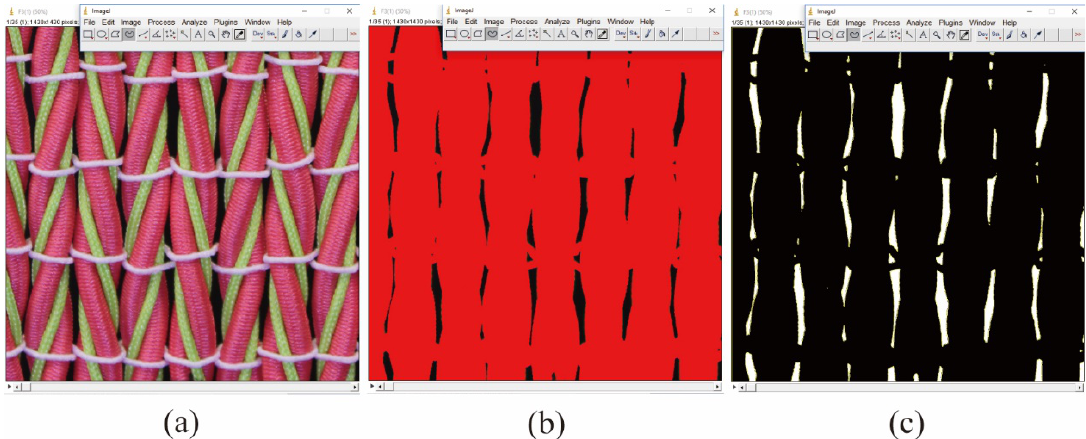
Figure 6. Conversion of the cropped image: ( a ) original image; ( b ) threshold color; ( c ) binary image.